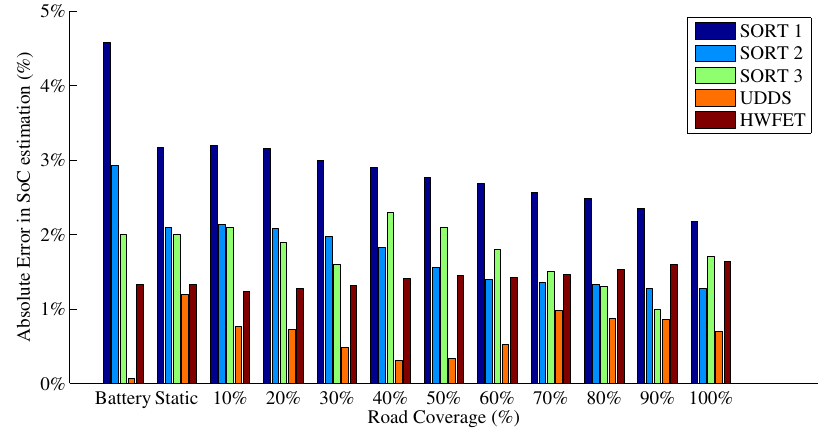
Figure 8. Percentage of the absolute error in SoC estimation for different driving